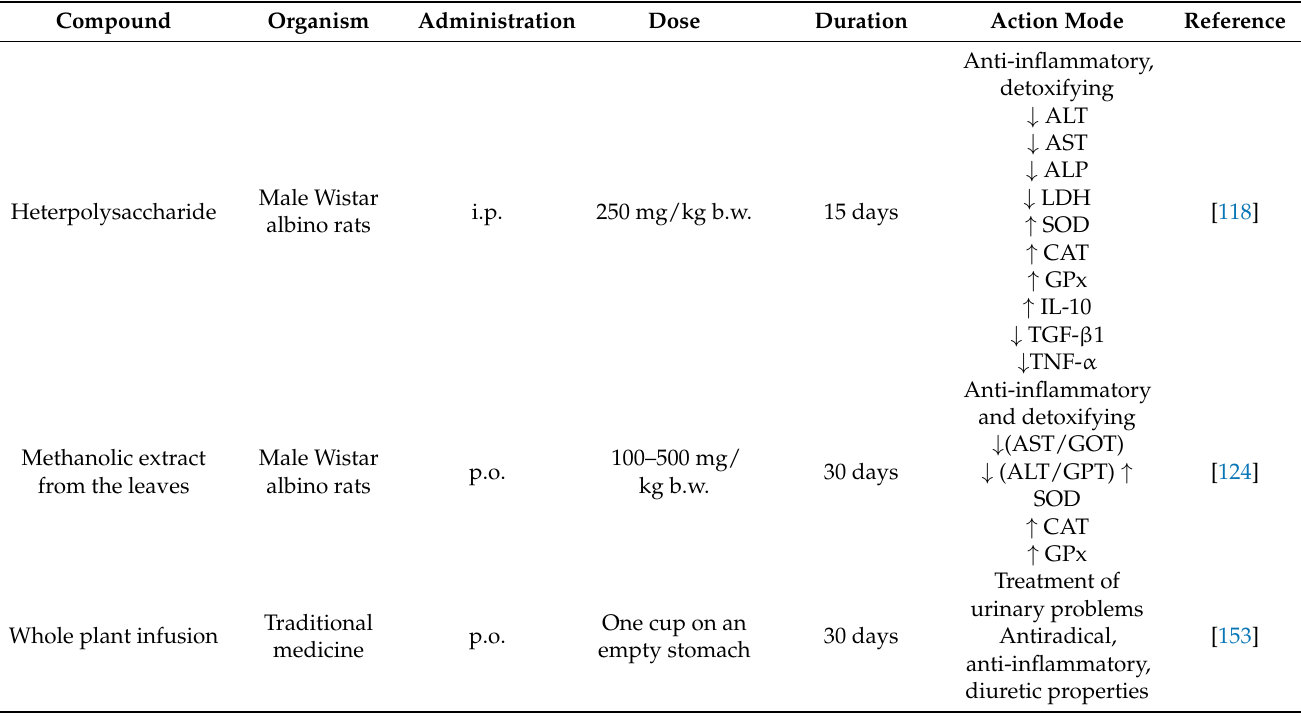
Table 4. Pharmacological properties of Lobularia maritima in the light of in vivo